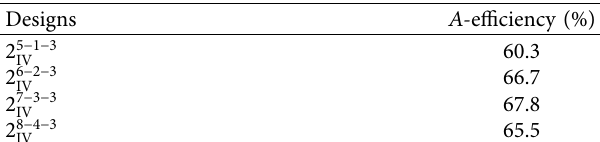
Table 6: Design efciency design and block generators for m � 5, 6, 7, and 8 with 8 choices set of size 2.